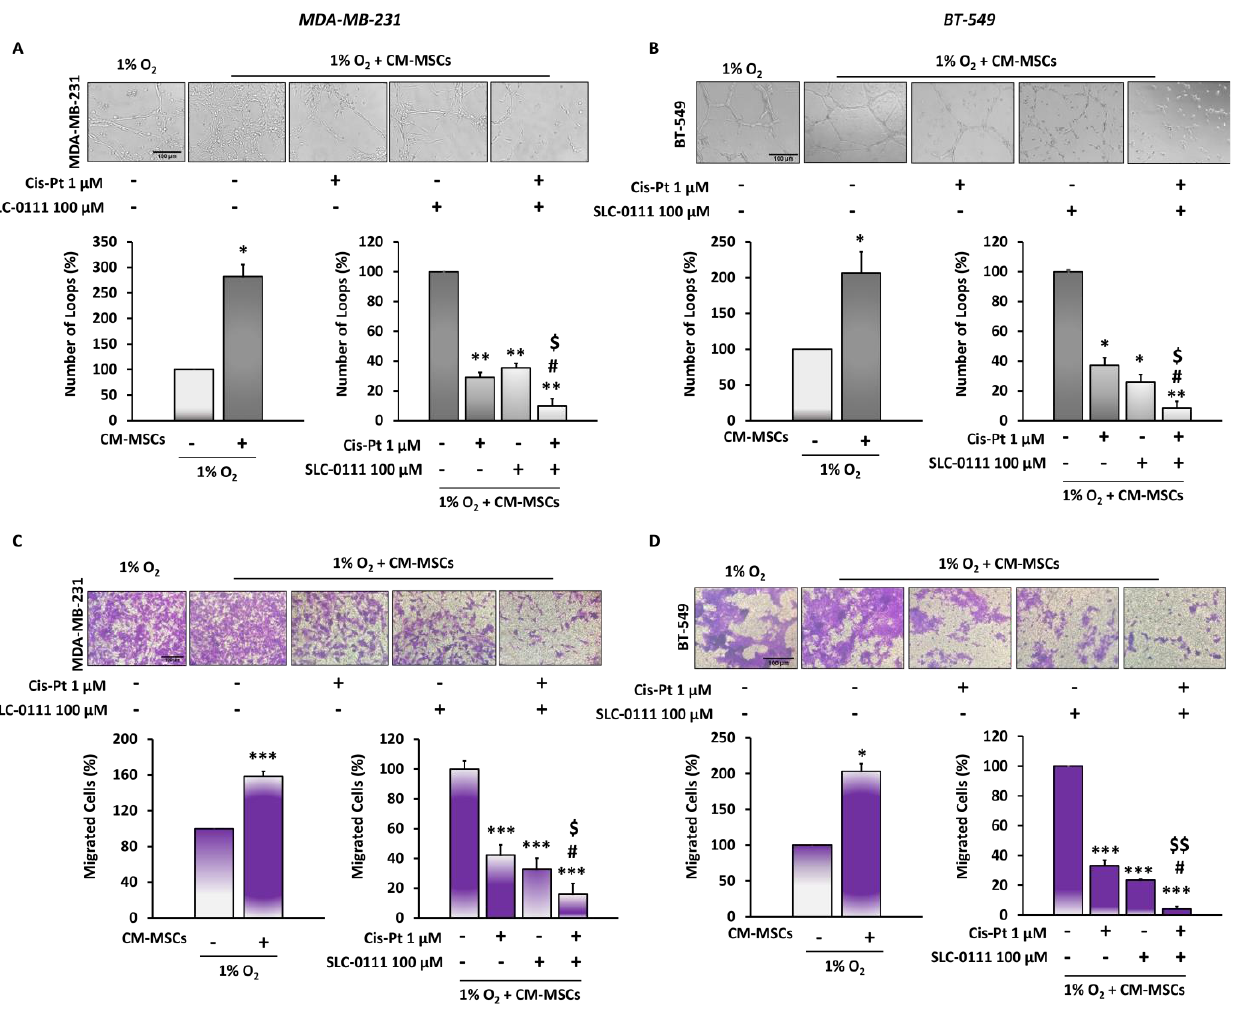
Figure 3. The combined treatment of SLC-0111 and Cis-Pt drastically reduces CM-MSC-induced TNBC cell migration and vessel-like structure formation. TNBC cells were grown for 24 h in hypoxia/CM-MSCs and treated with SLC-0111 (100 µM), Cis-Pt (1 µM) and a combination of the two drugs. VM of MDA-MB-231 ( A ) and BT-549 ( B ) was assessed by using 24-well plates pre-coated with 80 µL Matrigel/well and vascular loops were analyzed. Migration of MDA-MB-231 ( C ) and BT-549 ( D ) was performed by using Boyden chambers containing inserts of polycarbonate membranes with 8 μm pores. Medium containing 10% FBS was added to the lower chamber as chemoattractant. Magnification 10 x, scale bar = 100 µm. All the data are expressed as percentages, considering the untreated control cells as 100%. Bars depict mean ± SD of three independent experiments (vs untreated *** p < 0.0001, ** p < 0.001, * p < 0.01; vs. Cis-Pt $$ p < 0.0001, $ p < 0.001; vs. SLC-0111 ## p < 0.0001, # p < 0.001).